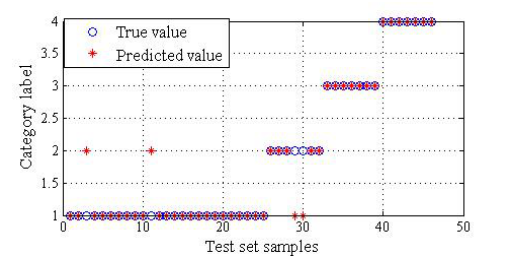
Fig. 11. Prediction results based on ABC-SVM